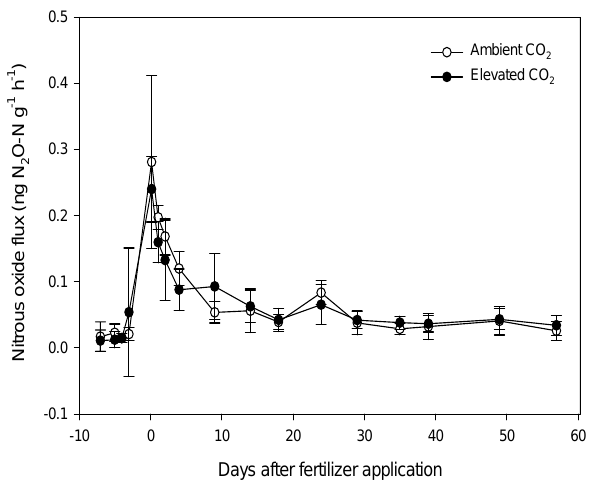
Fig. 2. Daily fluxes of N 2 O ( ŋ g N 2 O–N g ‐ 1 h ‐ 1 ) (Avg. ±SD) from temperate grassland soil exposed to elevated CO 2 and soil without elevated CO 2 treatment i.e. ambient incubated under controlled laboratory conditions following the application of NH 415 NO 3 and 15 NH 4 NO 3 .